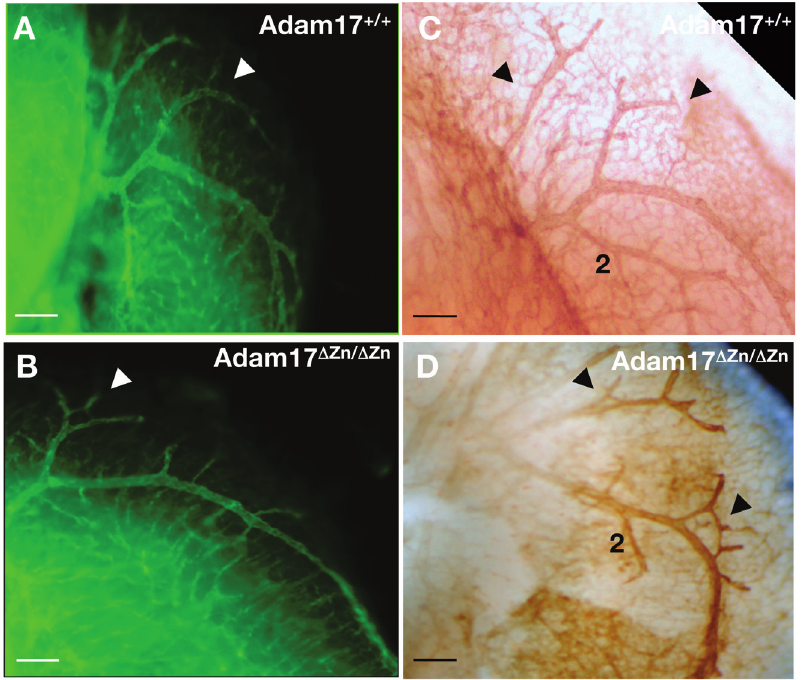
Figure 4. Abnormal fusion of branches in Adam17 D Zn/ D Zn cranial vessels. In addition to the stunted morphology, CD31 staining of E14.5 heads revealed abnormal joining of vessels at various branch points in the mutant embryos (3/4 embryos). Arrows indicate these fused branches in Adam17 D Zn/ D Zn embryos (B, D) and their absence in the wild-type counterparts (A, C). Scale bars are 200 m m.